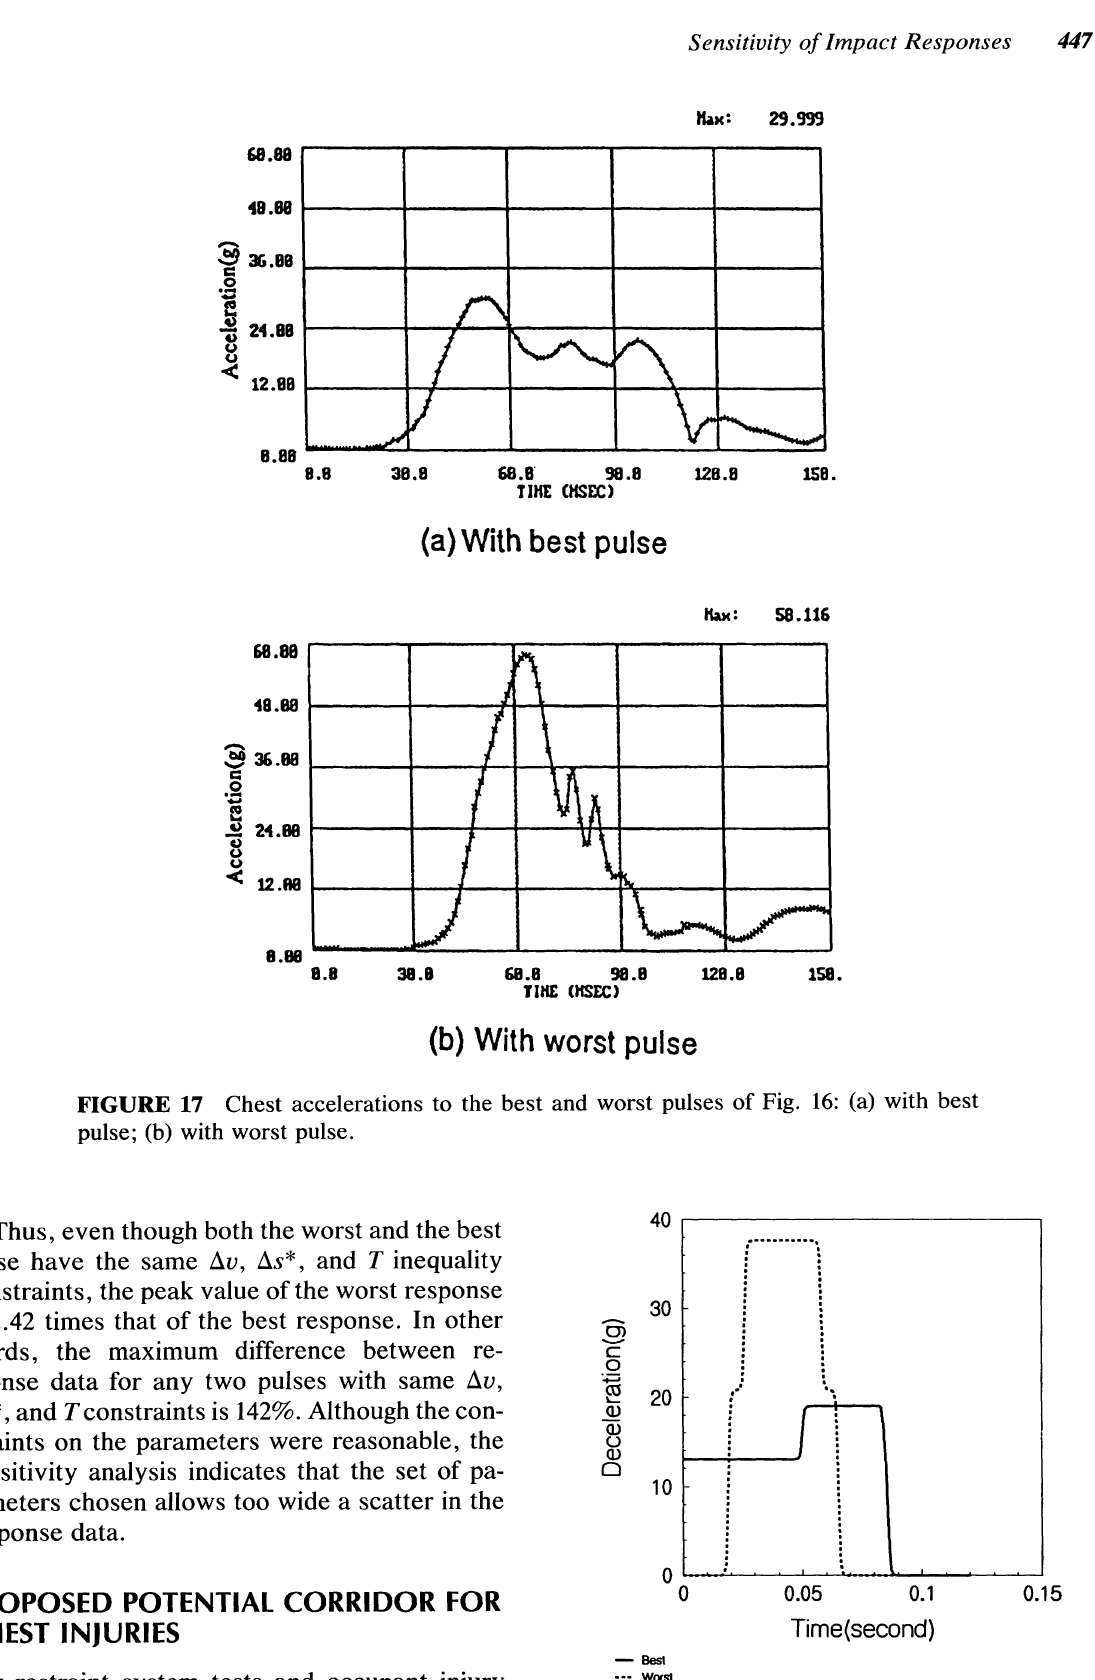
FIGURE 18 Best and worst